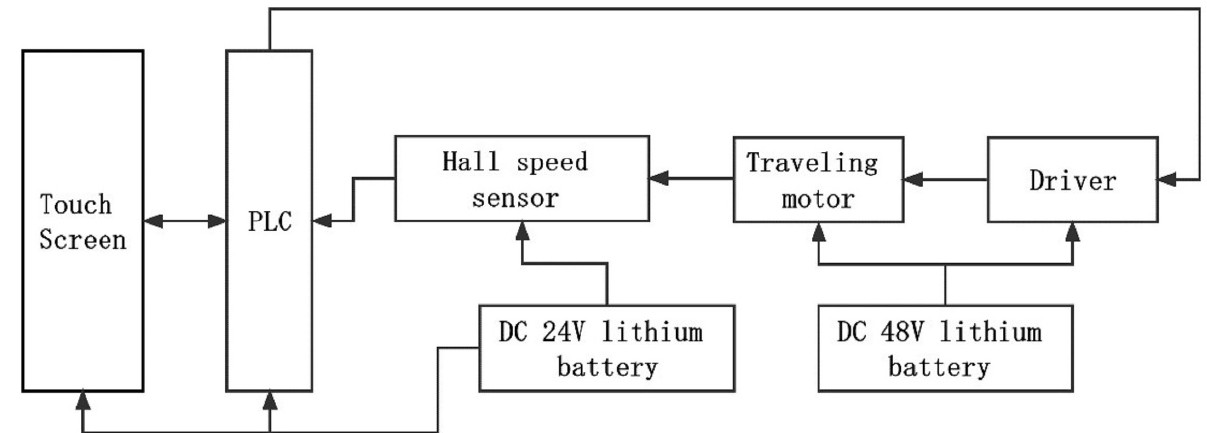
Figure 2. Automatic travel speed control system.